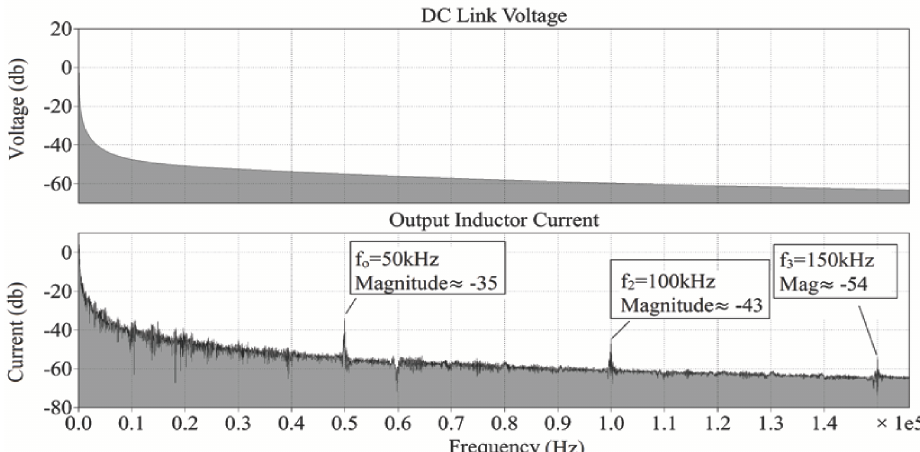
Figure 13. Frequency domain simulation of the converter depicting the output voltage V o and output inductor current i o high frequency